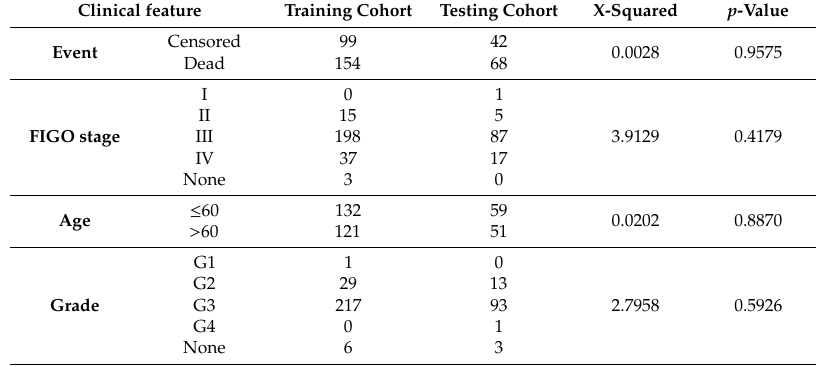
Table 1. Sample information of The Cancer Genome Atlas (TCGA) training and testing